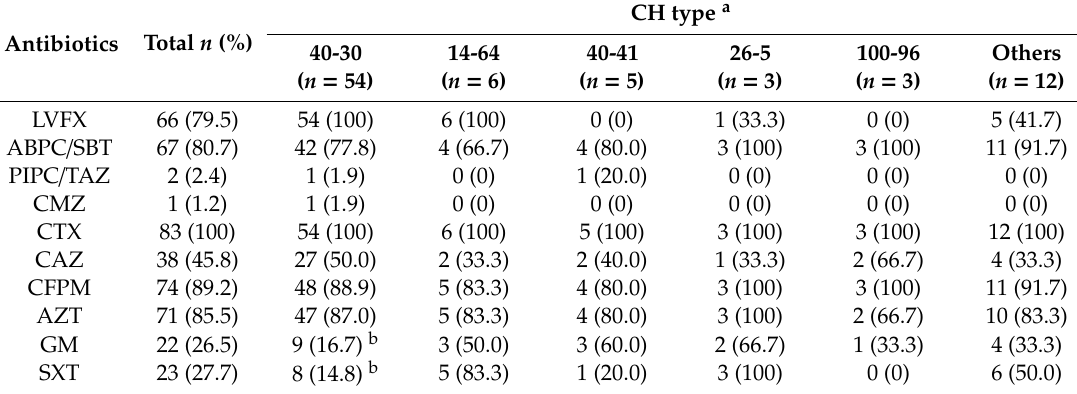
Table 1. CH ( fumC / fimH ) type and antimicrobial resistance of 83 extended-spectrum β